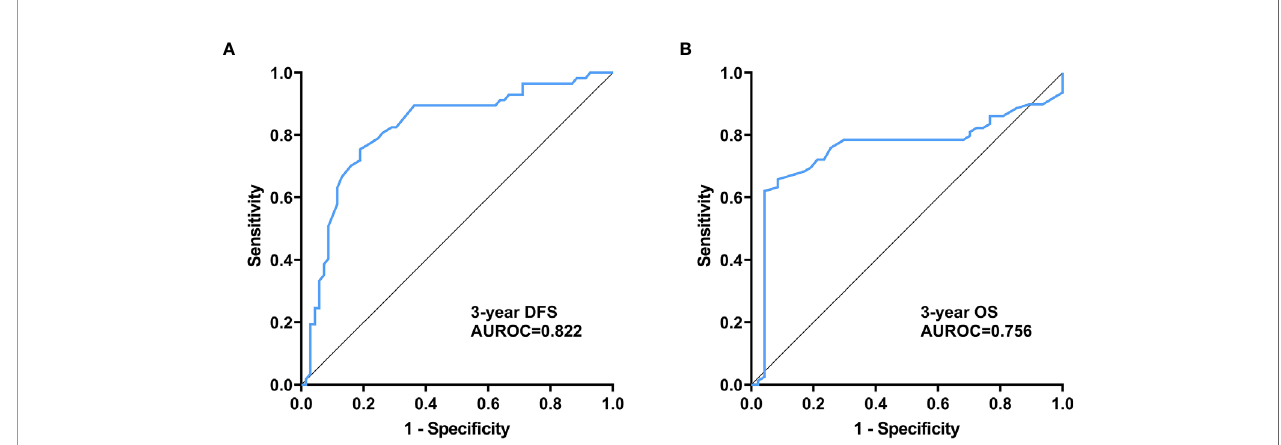
FIGURE 4 | Prognostic value of plasma exosome-derived SENP1 levels in melanoma patients (A) AUC for plasma exosome-derived SENP1 levels for predicting 3- year DFS of melanoma patients; (B) AUC for plasma exosome-derived SENP1 levels for predicting 3-year OS of